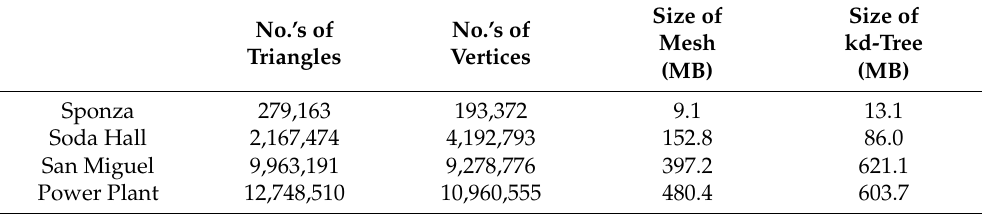
Table 1. Memory spaces required by the 3D geometries of example 3D scenes. The sizes of the kd-trees that are produced by the de facto standard algorithm, based on combinations of the tree construction and representation methods [21,22], are compared to those of the actual triangular mesh data, stored in the indexed-face-set format. As expected, the essential kd-tree structure usually introduces significant memory overhead because of the inevitable replication of triangles in the resulting accelerating tree